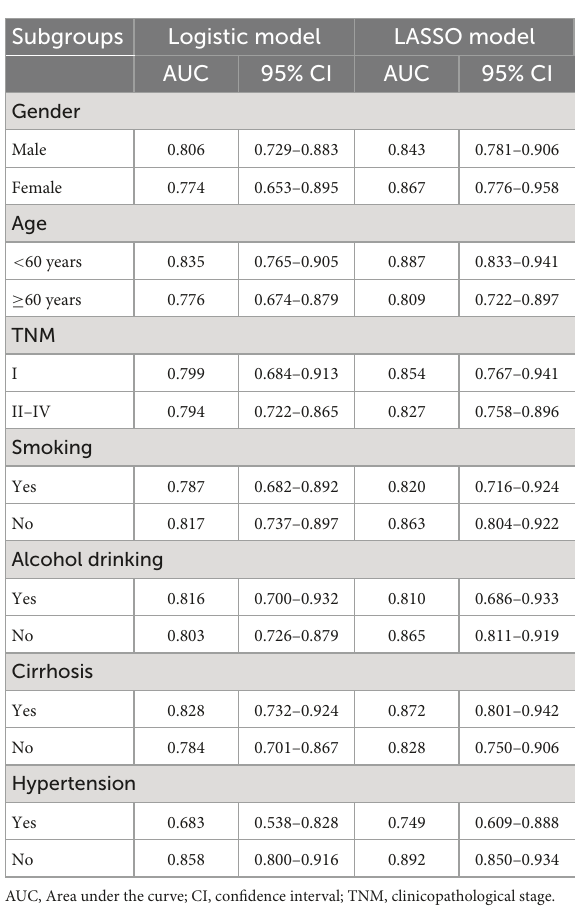
TABLE 3 Incidences of ARDS classified by risk scores in the development cohort and validation cohort.